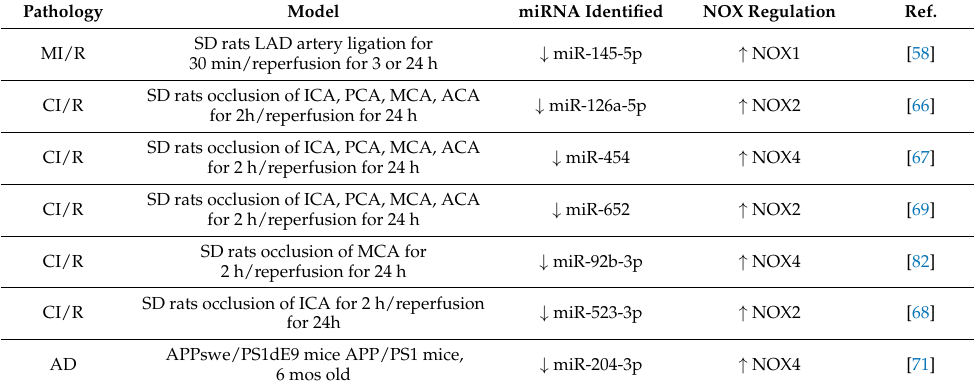
Table 3. Differential Expression of miRNAs and NOX Isoforms in Models of Ischemia/Reperfusion Injury Legend: SD—Sprague Dawley; MI/R—Myocardial Ischemia/Reperfusion; LAD—Left Ante- rior Descending Coronary Artery; CI/R—Cerebral Ischemia/Reperfusion; ICA—Internal Carotid Artery; PCA—Posterior Cerebral Artery; MCA—Middle Cerebral Artery; ACA—Anterior